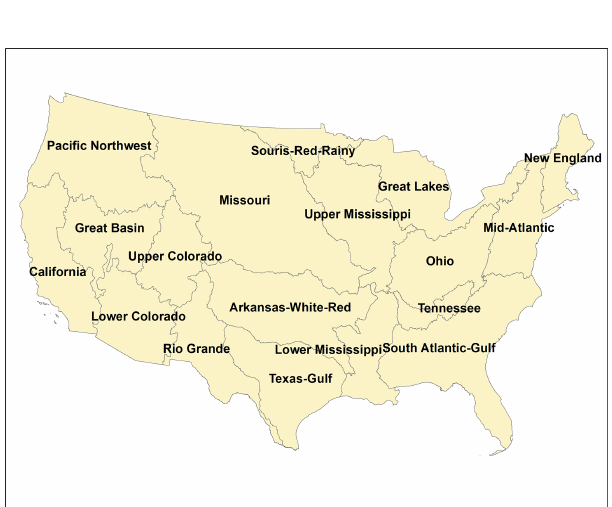
Figure 1. Map of 18 hydrologic units in the contiguous US (recre- ated from the US hydrologic unit map: https://water.usgs.gov/GIS/ regions.html, last access: 17 December